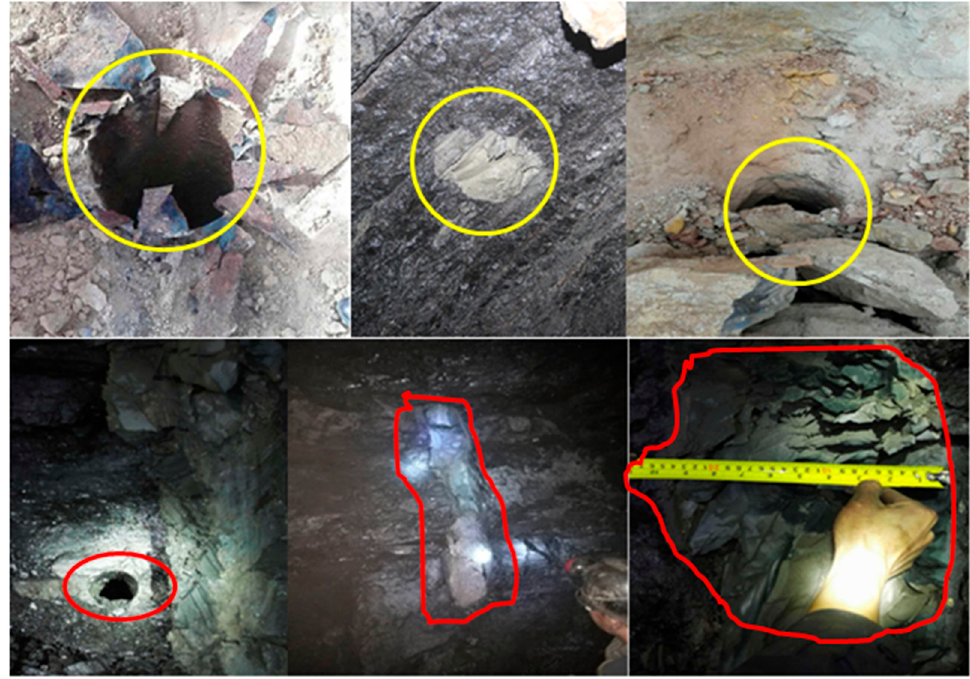
Figure 5. The positional relationship between the Ma tan 31 oil well and the coal-measure